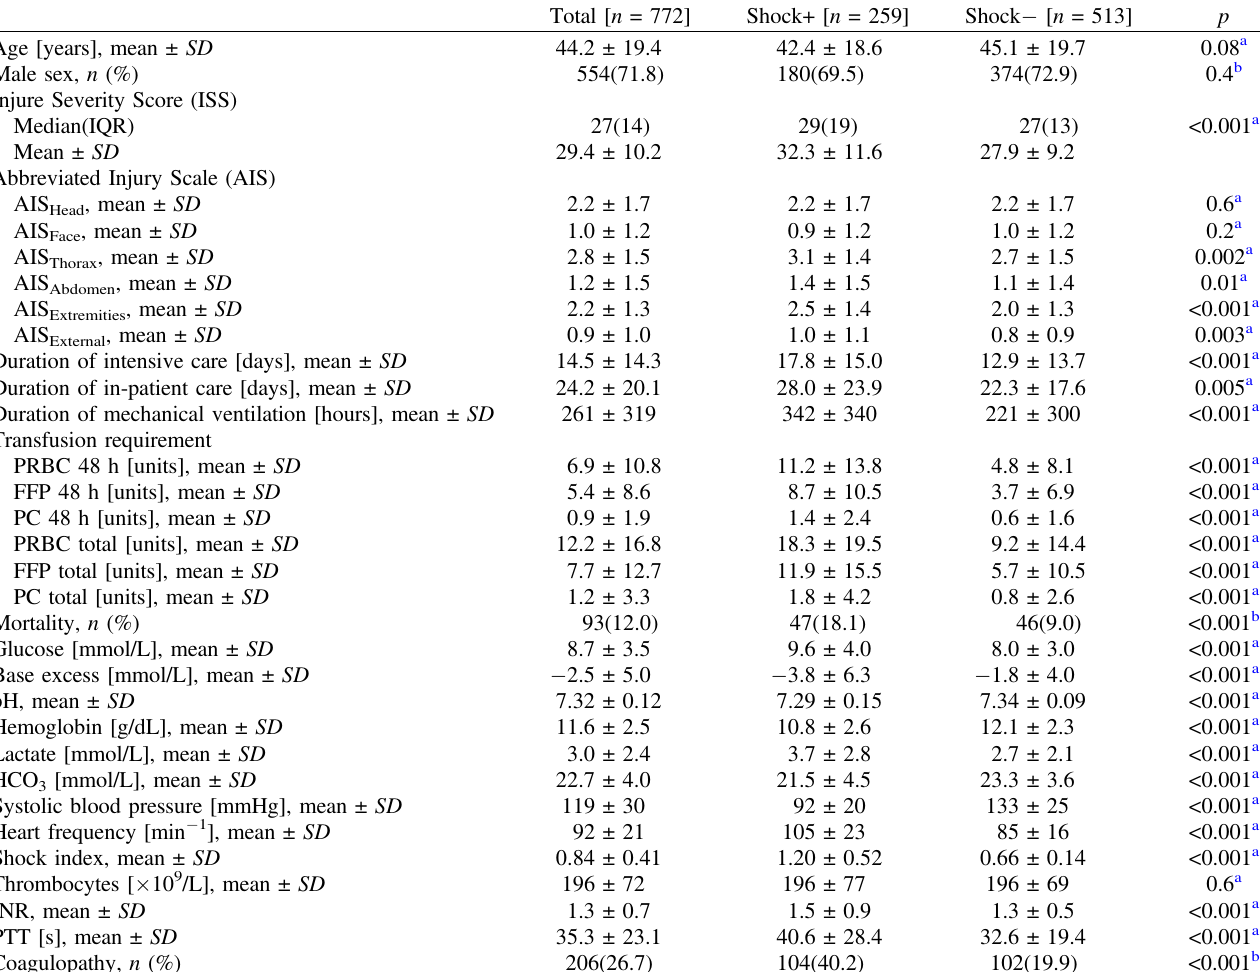
Table 1. Demographic, baseline and outcome data of multiply injured patients with and without shock at admission.